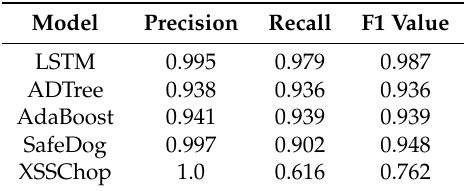
Table 2. Comparative experiment of the XSS detection model for